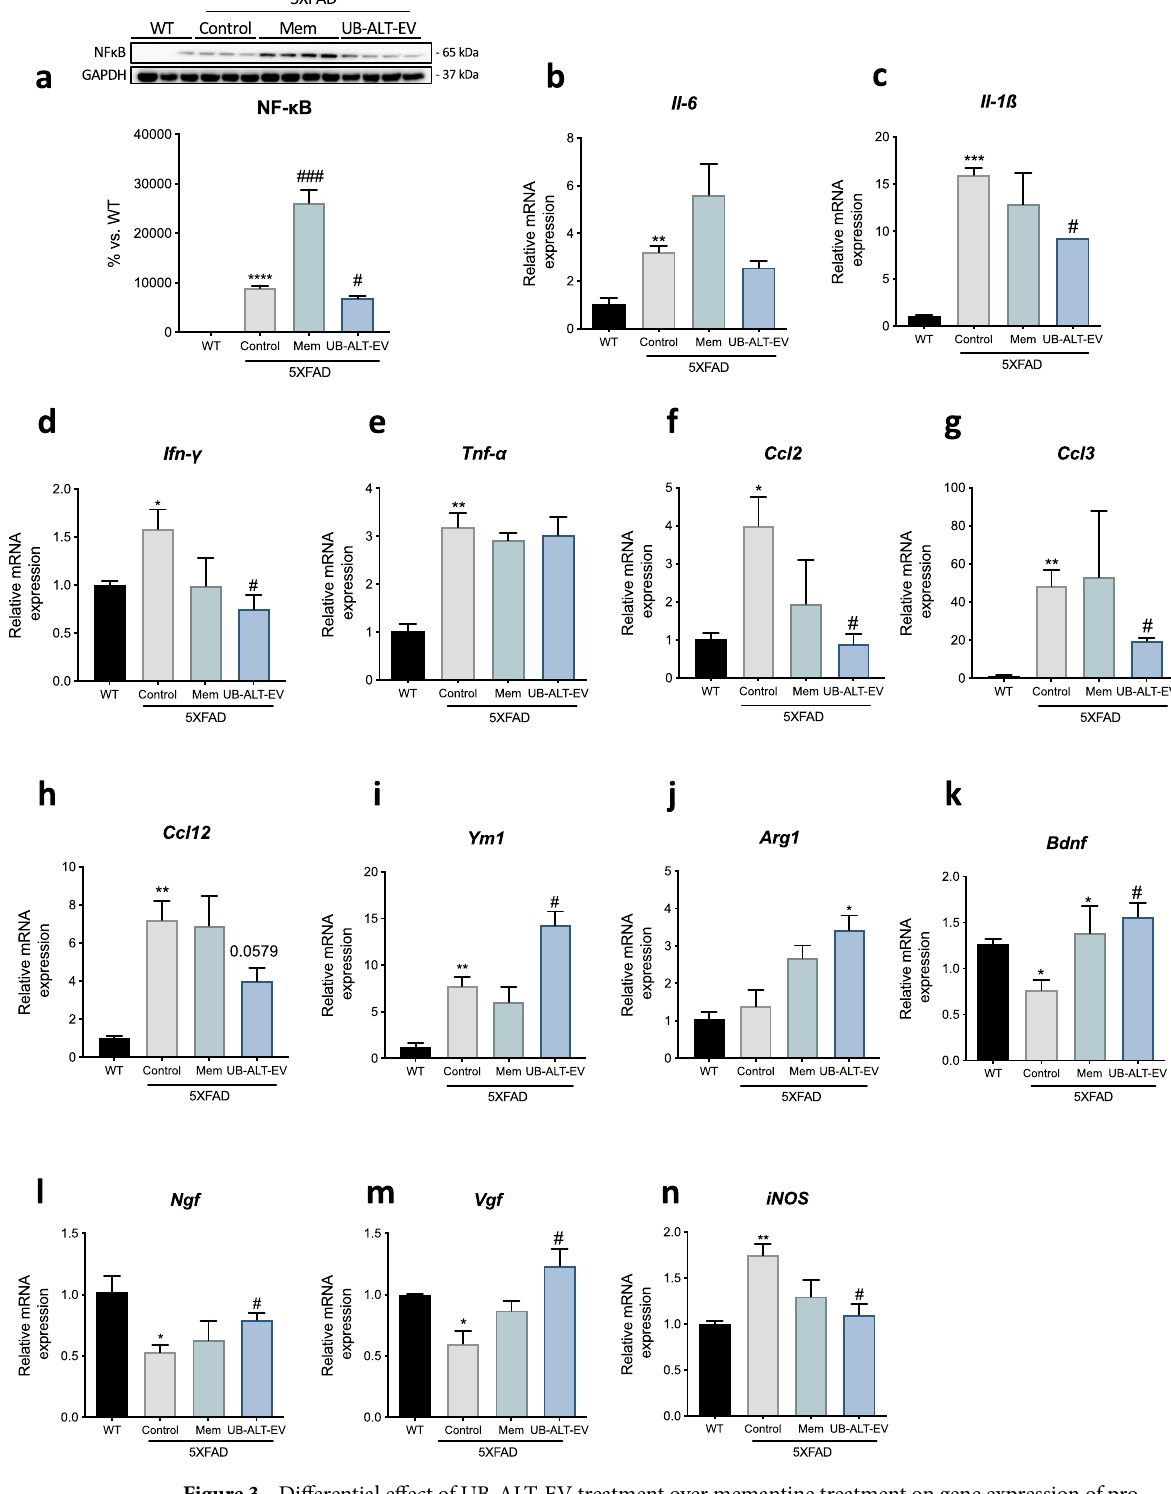
Figure 3. Differential effect of UB-ALT-EV treatment over memantine treatment on gene expression of pro- inflammatory and anti-inflammatory microglial markers in 5XFAD mice. Representative Western Blot and quantification for NF-κB ( a ). Values in bar graphs are adjusted to 100% for protein levels of the wild type (WT). Representative gene expression for Il-6 ( b ), Il-1β ( c ), Ifn-γ ( d ), Tnf-α ( e ), Ccl2 ( f ), Ccl3 ( g ), Ccl12 ( h ), Ym1 ( i ), Arg1 ( j ), Bdnf ( k ) Ngf ( l ), Vgf ( m ) and iNOS ( n ) . Values are the mean ± Standard error of the mean (SEM); (n = 3 for WT and Control groups and n = 4 for Mem and UB-ALT-EV groups. For WT vs. 5XFAD Control groups data was analyzed using a two-tail Student’s t-test, and for 5XFAD groups a standard one-way ANOVA followed by Tukey post-hoc analysis was performed. *p < 0.05; **p < 0.01; ***p < 0.001; ****p < 0.0001 for WT vs. Control. # p < 0.05; ### p < 0.001 for Mem or UB-ALT-EV vs.